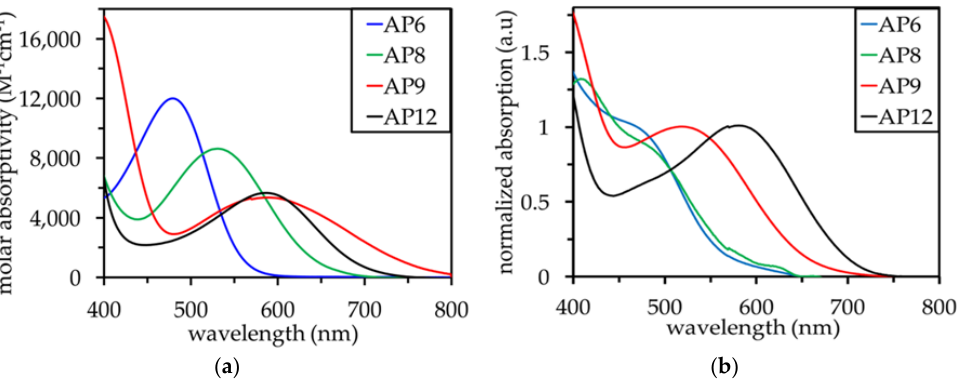
Figure 2. ( a ) Molar absorptivities of AP6 , AP8 , AP9 , and AP12 in DCM and ( b ) normalized absorption on TiO 2 . Table 1. Optical and electrochemical data of AP6 , AP8, AP9 , and AP12 . Absorbance Data